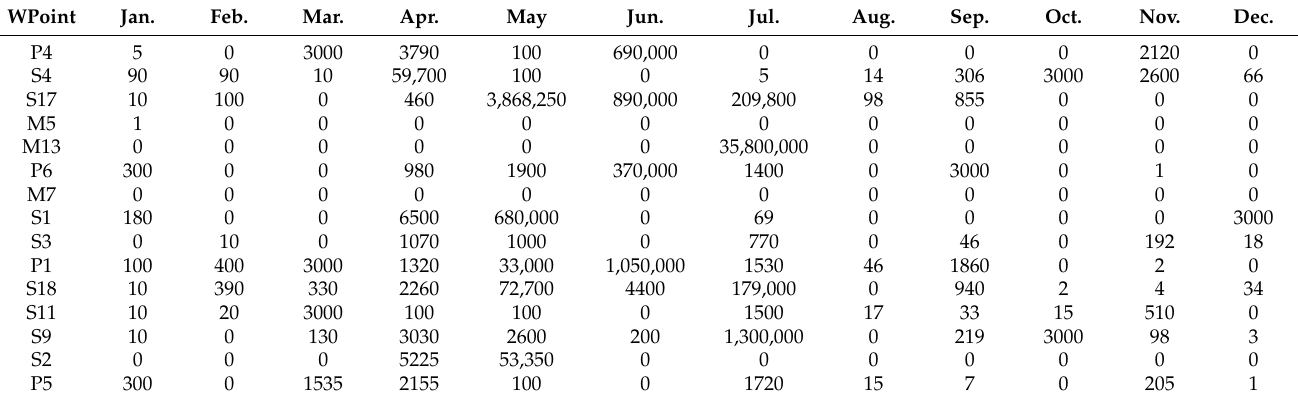
Table A1. Monthly FC count for 15 water point samples of type “Pipe/Cistern” for the year 2017. WPoint